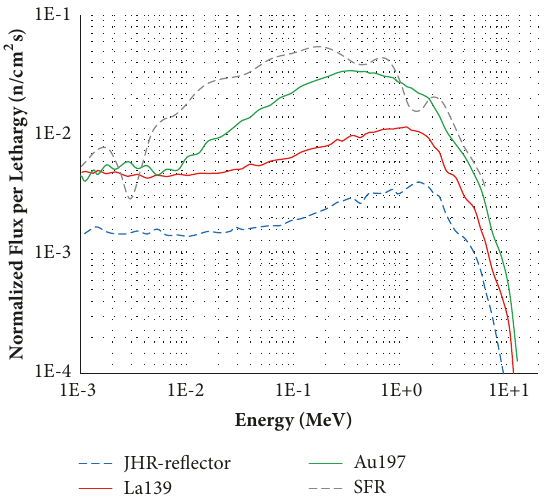
Figure 9: Effect of 139 La- and 197 Au-based screen on the JHR reflector neutron spectrum.